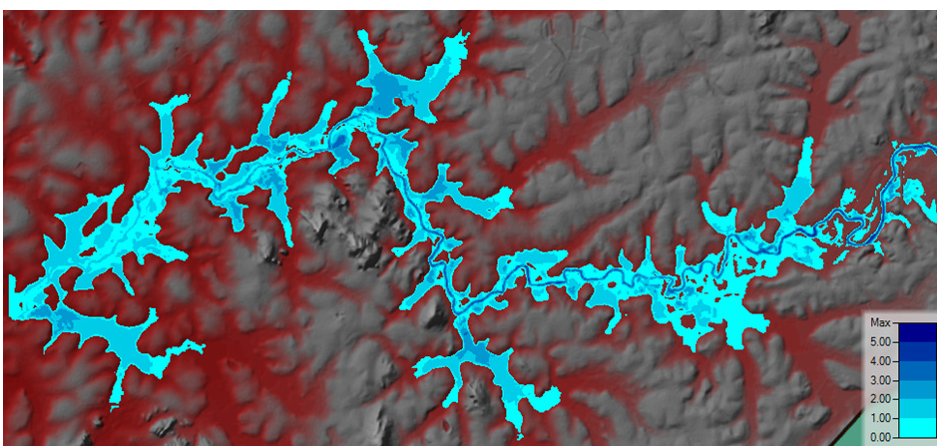
Figure 8: Forecasted flood area for flood event occurred in May